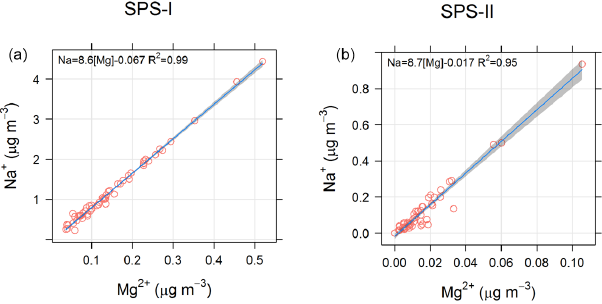
Figure 23. Scatter plot of Mg and Na for SPS-1 (a) and SPS-II (b) .